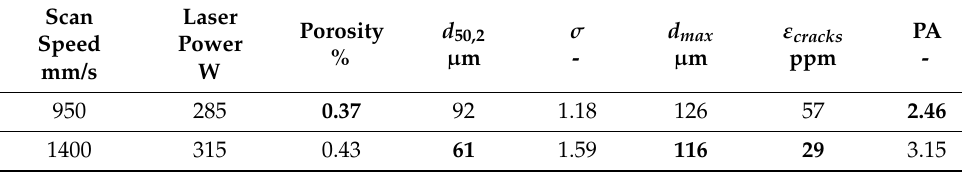
Table 5. Selection of process conditions, optimal values are marked